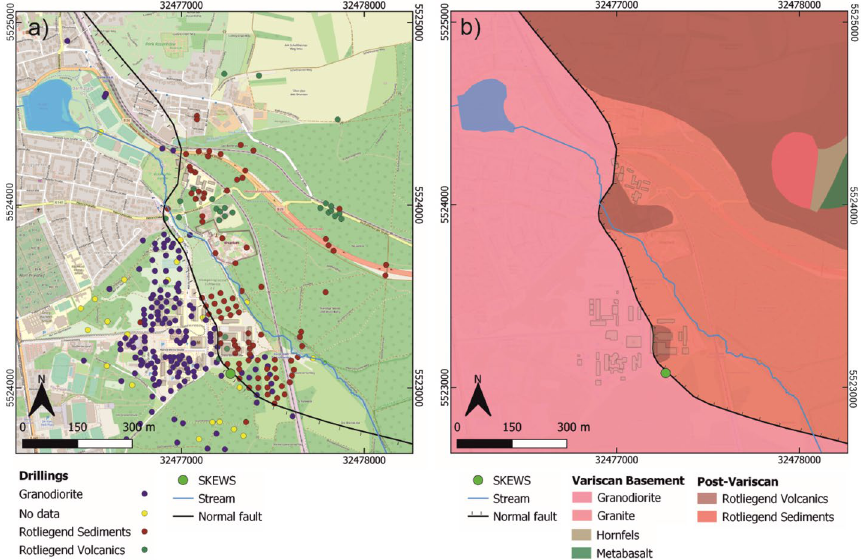
Fig. 3 a Drilling positions colored according to the explored lithology. b Geological map of the Lichtwiese campus (modified after Klemm 1911 and Fahlbusch